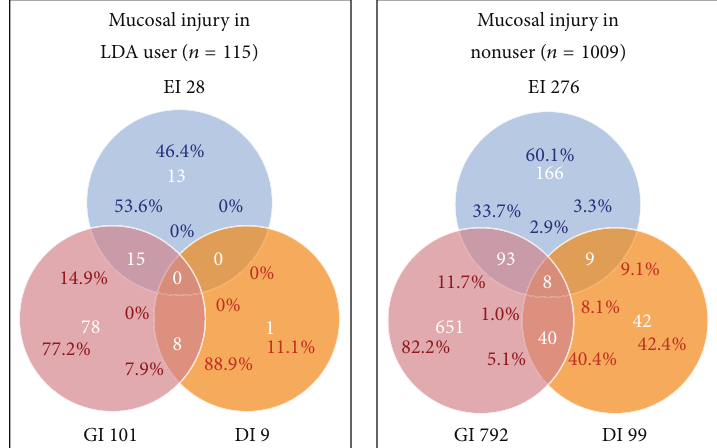
Figure 3: Proportions of patients with different forms of mucosal injury. In patients who had esophageal mucosal injury, the percentage with concurrent gastric mucosal injury was 53.6% for LDA users versus 33.7% for nonusers. In patients who had duodenal mucosal injury, the percentage with concurrent gastric mucosal injury was 88.9% for LDA users versus 40.4% for nonusers. EI = esophageal mucosal injury, GI = gastric mucosal injury, and DI = duodenal mucosal